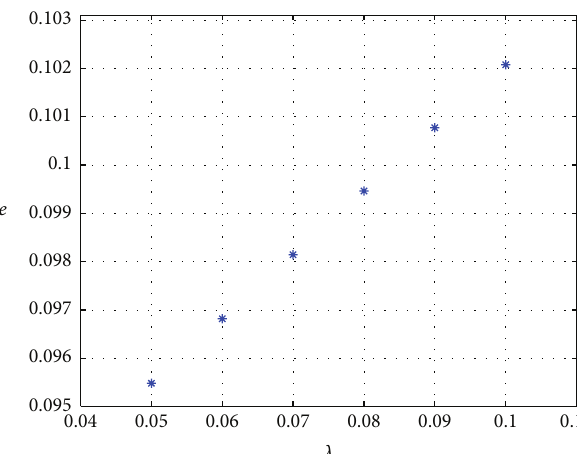
Figure 6: Diagram for the optimal effort versus shadow cost with uncertainty.